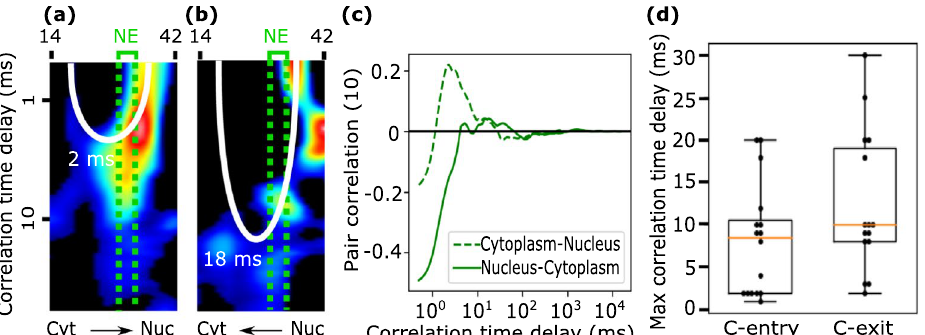
Figure 6. pCF pixel-by-pixel analysis Representative results of a pCF(10) analysis calculated pixel-by-pixel along a scanned confocal line across the cytoplasm (left) and the nucleus (right) of a DENV infected cell. Panels ( A , B ) show pCF(10) curves as a function of the NE distance (the closer to the NE, the lighter the color). Pixels closer to each other (similar shades of blue or red) tend to have similar correlation curves. In panels ( C , D ) pCF(10) curves at 1 and 2 μm from NE are highlighted showing the presence of positive correlation peaks close to the NE (in light color) but the presence of only one positive correlation peak far from the NE (in dark color).